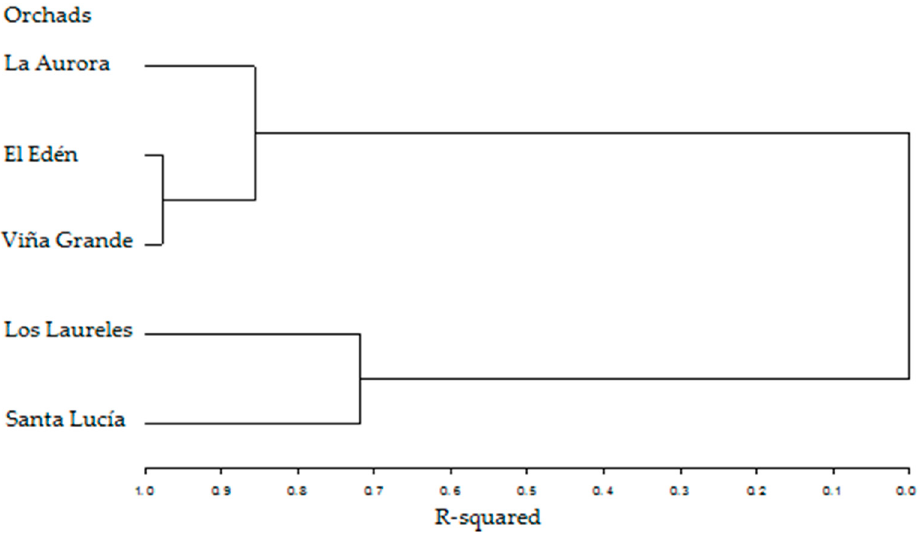
Figure 3. Tree diagram with the clusters of the orchards.